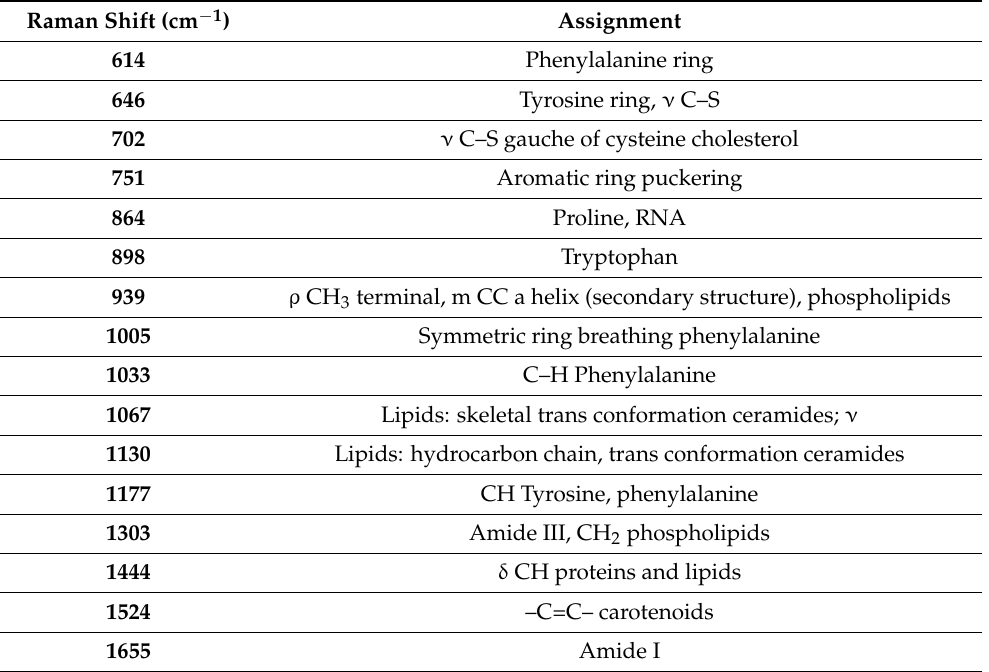
Table 2. Raman band assignments in SC